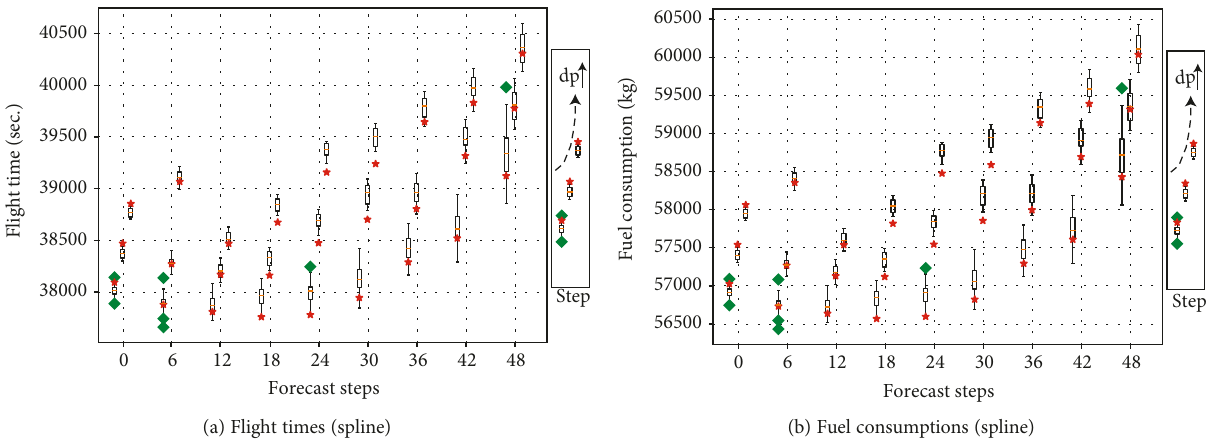
Figure 12: EGLL to SBGL results. Boxplots denote predicted uncertainties (based on EPS data and computed using the robust fl ight planning algorithm); red stars denote realized values (based on reanalysis